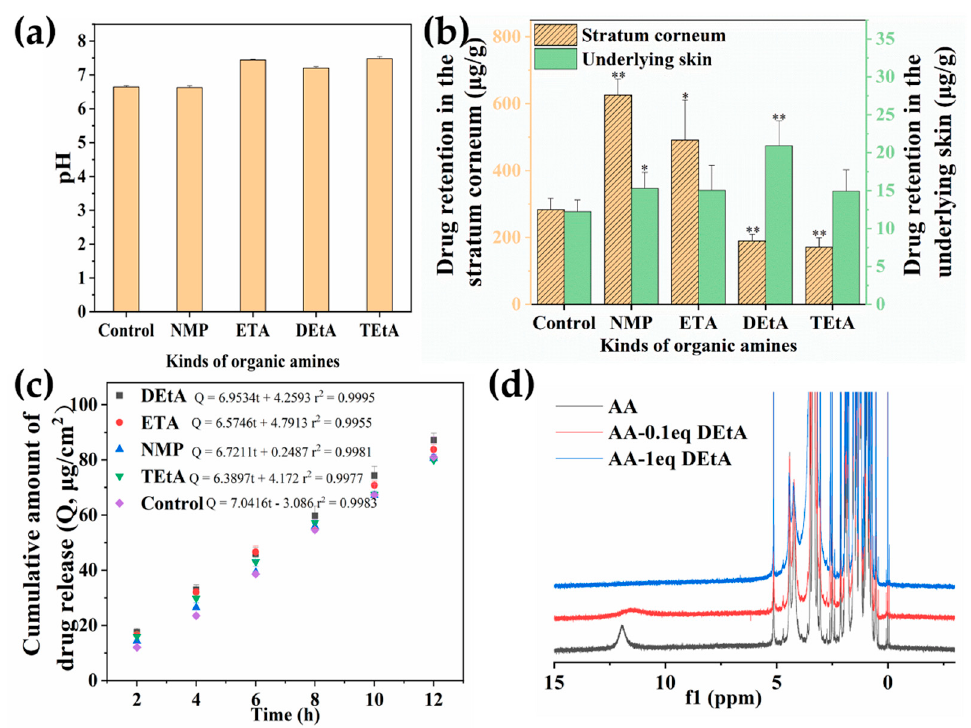
Figure 5. ( a ) The pH of the prescriptions with different kinds of organic amines; ( b ) effects of different organic amines on the content in the stratum corneum and remaining skin compared with the control group (AA-loaded hydrogel without any organic amine); ( c ) effects of different organic amines on the release of AA; ( d ) 1 H-NMR of AA, AA-DEtA (1:0.1), AA-DEtA (1:1). (NMP: N-Methylpyrrolidone; ETA: ethanolamine; DEtA: diethylamine; TEtA: triethylamine; AA: Asiatic acid; *: p < 0.05; **: p < 0.01).